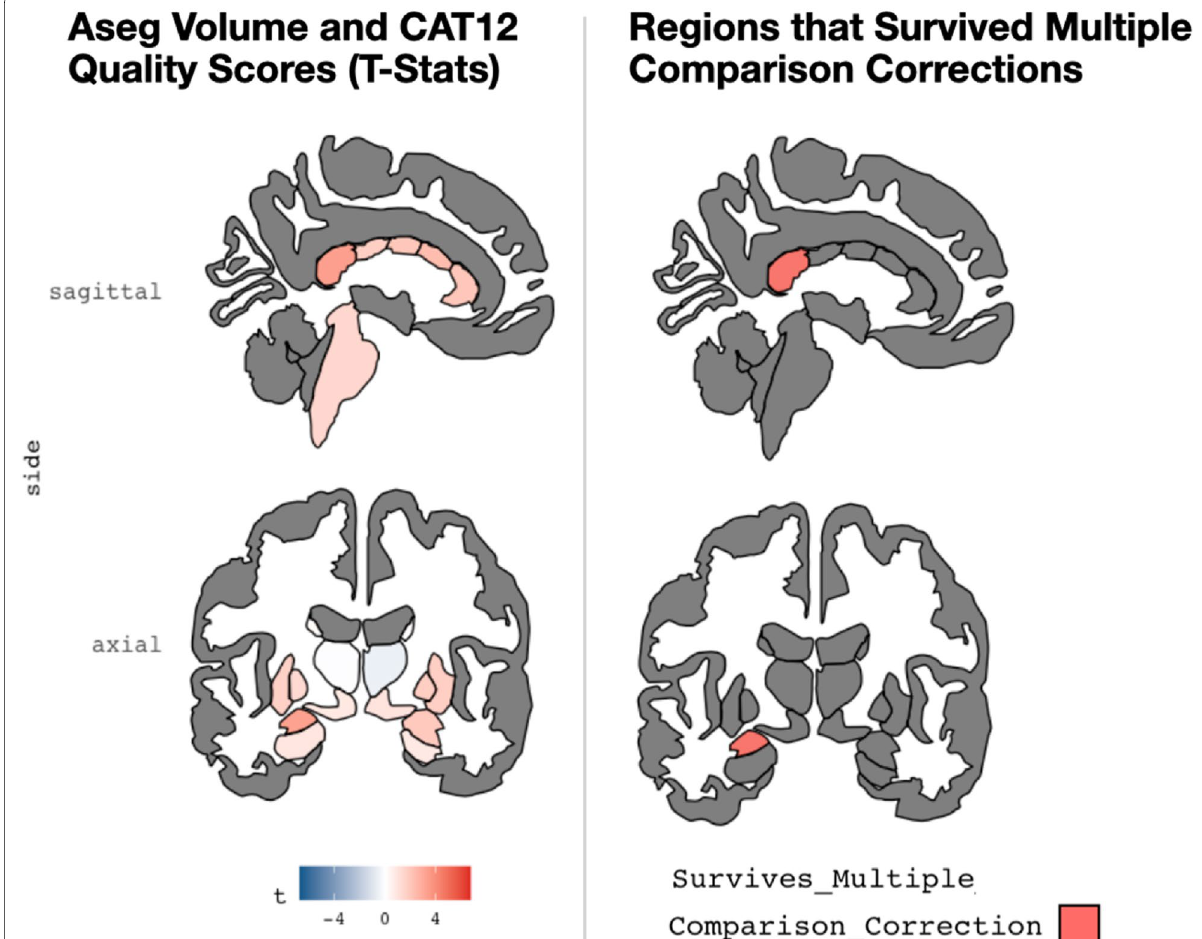
Fig. 7 A graphic depiction (from the R library ggseg) showing associations between image quality (assessed by the CAT12 Toolbox) and subcortical volumes. This is shown for the Freesurfer ASEG atlas. Coronal (left) and sagittal (right) views are shown. The left panel shows the t-statistic for the relation in each subcortical volume, while the right panel shows parcels where the relation between volume and image quality survives multiple